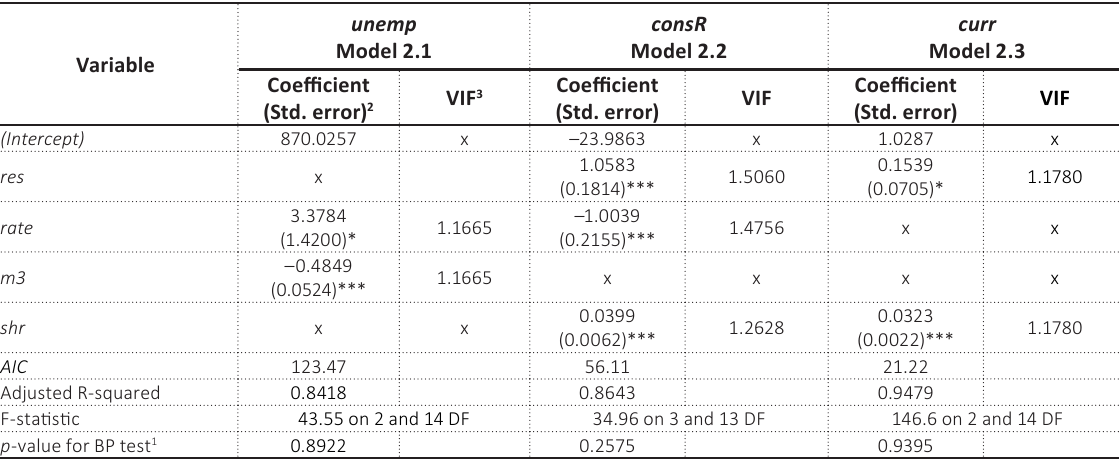
Source: Estimated by the